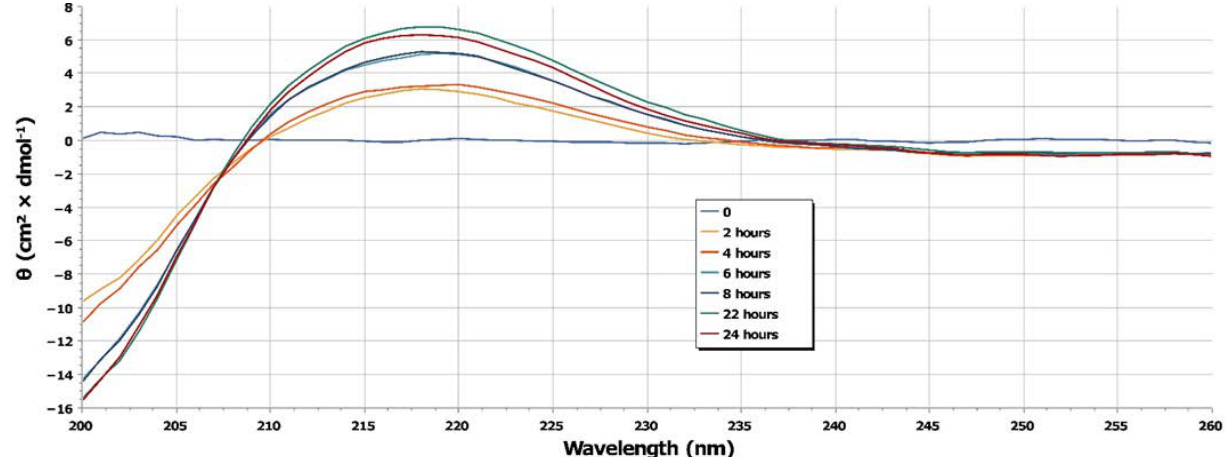
Figure 2. Electrospray ionization time-of-flight (ESI-TOF) deconvoluted mass spectrum of the sam- ple after 2 h of incubation.